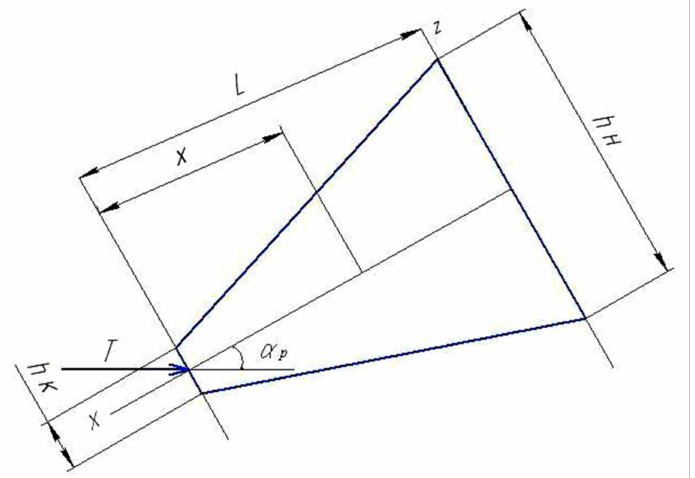
Figure 5. Diagram determining the calculated parameters of the cross-section under the condition of the optimal distribution of forces.